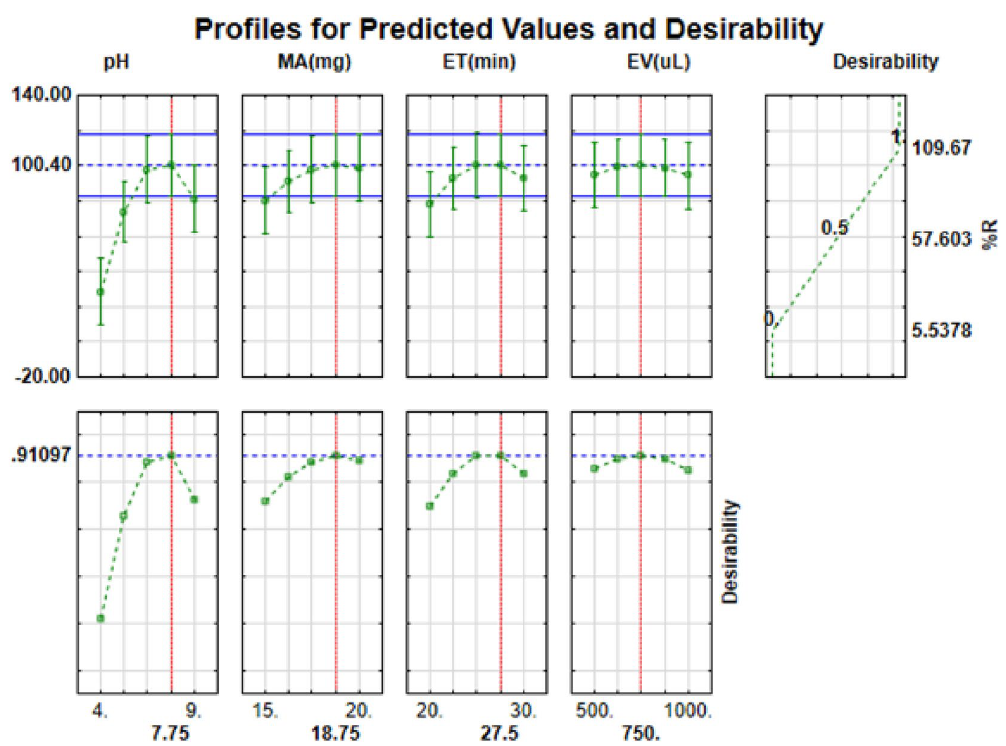
Figure 3. Desirability function for optimization of independent parameters for the targeted steroid hormones. A TIBCO® Statistica™ package version 13 (StatSoft, Palo Alto, CA, USA) (https:// edeli very. tibco. com/ store front/ eval/ tibco- stati stica- deskt op/ prod1 1850.